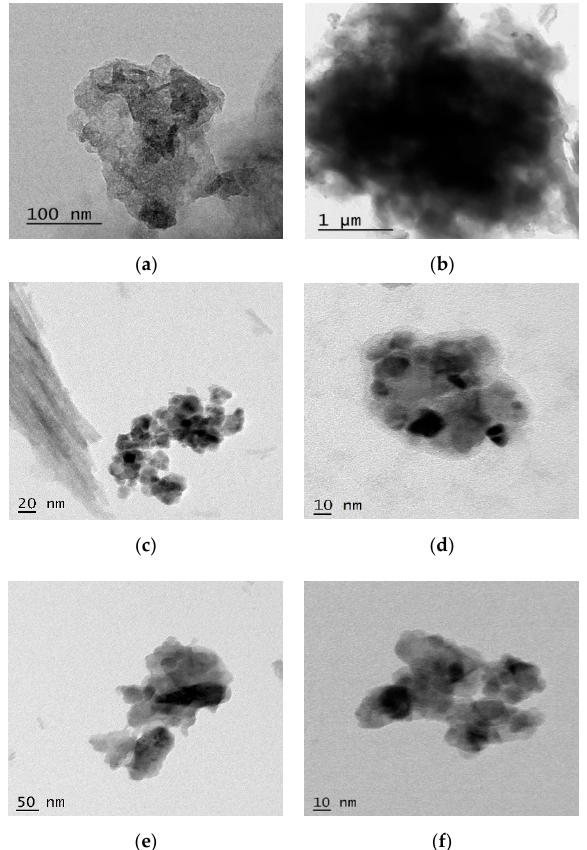
Figure 1. SEM image of nanoscale zero-valent iron (nZVI) particles: ( a , b ) from chemical synthesis; ( c , d ) using neem leaves; ( e , f ) using mint leaves.